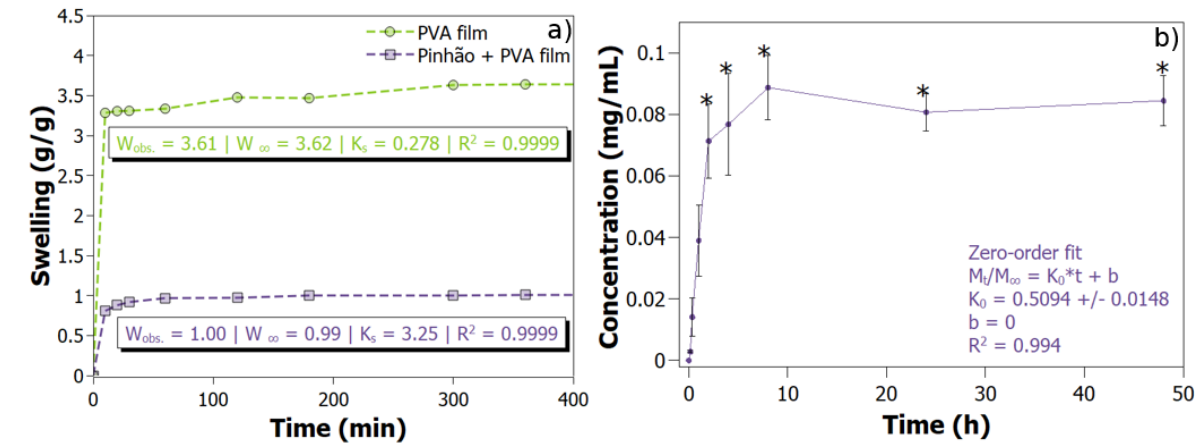
Figure 5. ( a ) swelling ratio of the studied for PVA films and for PVA/pinhão films; ( b ) Drug Release PVA/pinhão film, concentration (mg extract mL −1 ), zero-order model with R 2 prediction: 0.994, with a prediction error of 7.2 × 10 −3 at water, 37 °C. All data points are plotted as the mean ± SD (n = 3). Treatments followed by * in each concentration do not differ by Tukey’s test ( p < 0.01).